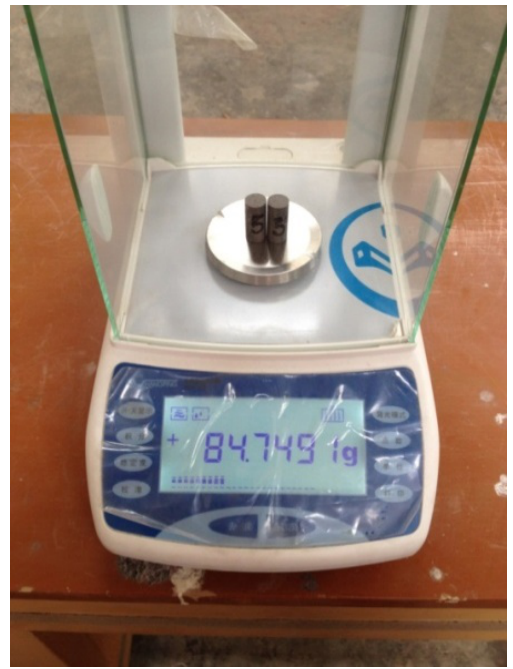
Figure 2. Weighing